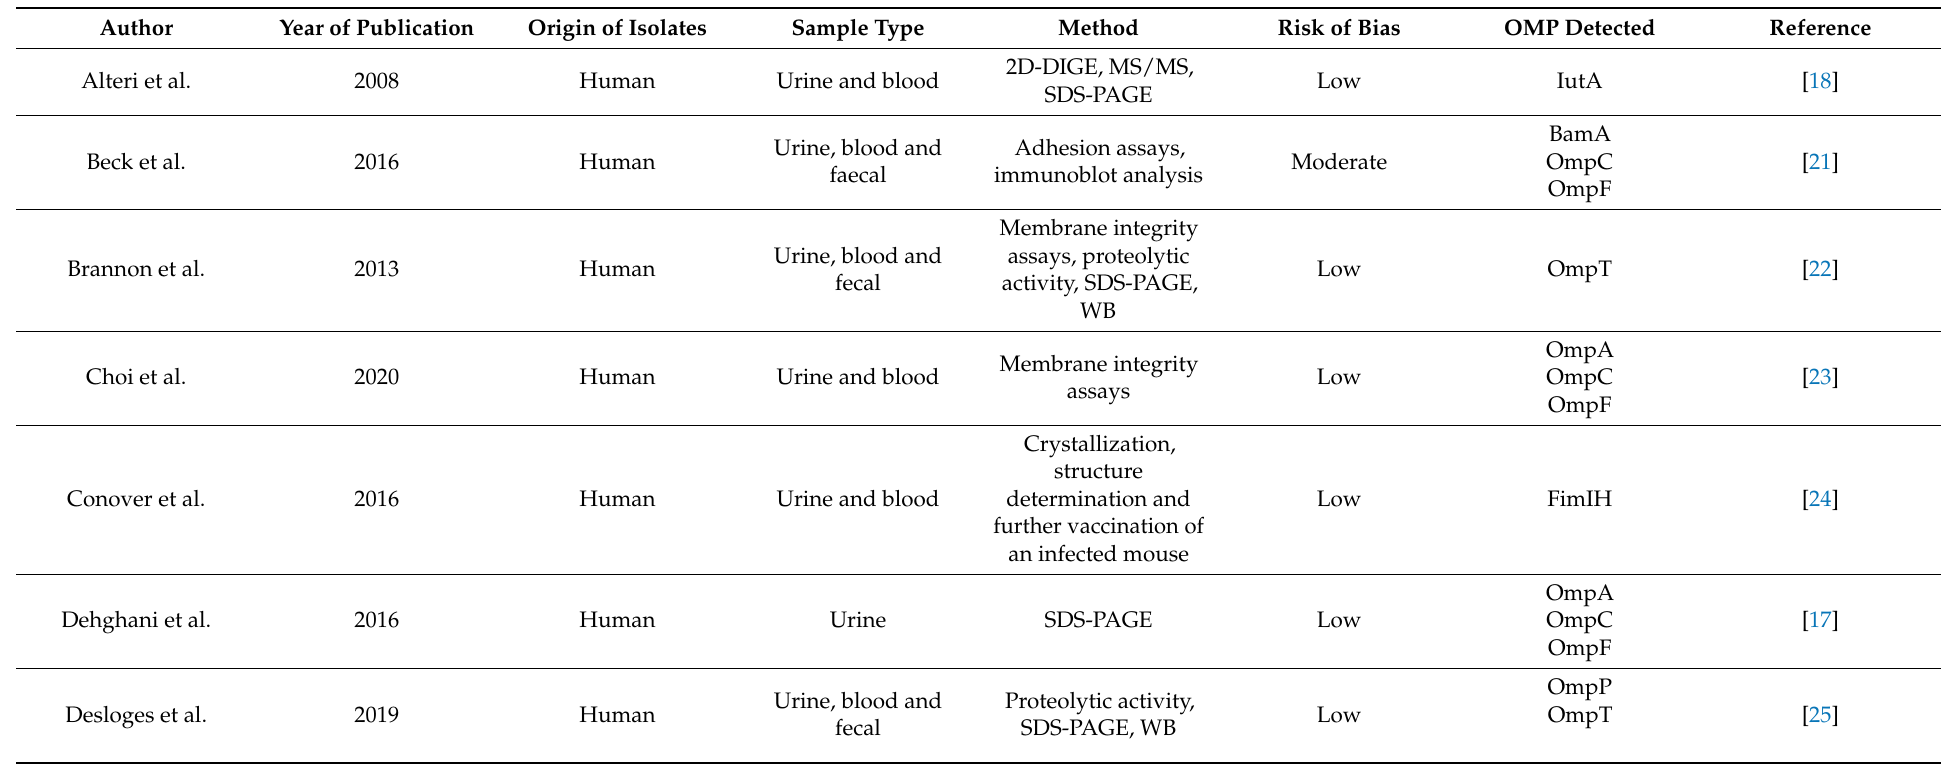
Table 1. Characteristics of included studies after full assessment. Data from the final twenty-nine studies were extracted and systematized. Author; year of publication; the species of the isolates and the type of the sample collected; and the method used for protein characterization and the OMP detected were listed. The RoB assessed through the adaptation of NOS quality scale was also included for each